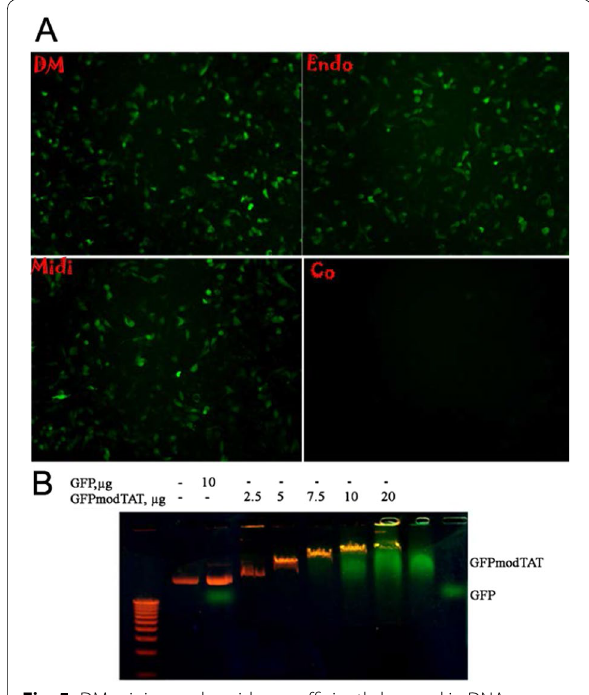
Fig. 5 DM miniprep plasmids can efficiently be used in DNA quality-sensitive applications. A The transfection efficiency of PC3 prostate cancer cells with the DM (DM) minipreps plasmid was similar to that of the ZymoPURE-EndoZero Midiprep (Endo) and QIAGEN Midi (Midi) Kit-derived results. One of three independent experiments is reported. B pcDNA 3.1/His/LacZ plasmid purified with the DM minipreps method forms GFP-TAT-fusion protein complexes. pcDNA 3.1/His/LacZ plasmid was premixed with various amounts of the GFP-TAT fusion protein as described in methods. Samples were resolved by agarose gel electrophoresis. GFPmodTAT and GFP written on the right correspond to pure